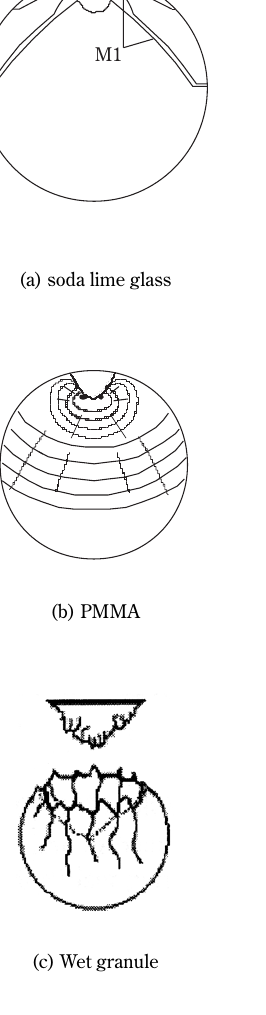
Fig. 3 Intermediate impact velocity regime failure patterns of sev- eral